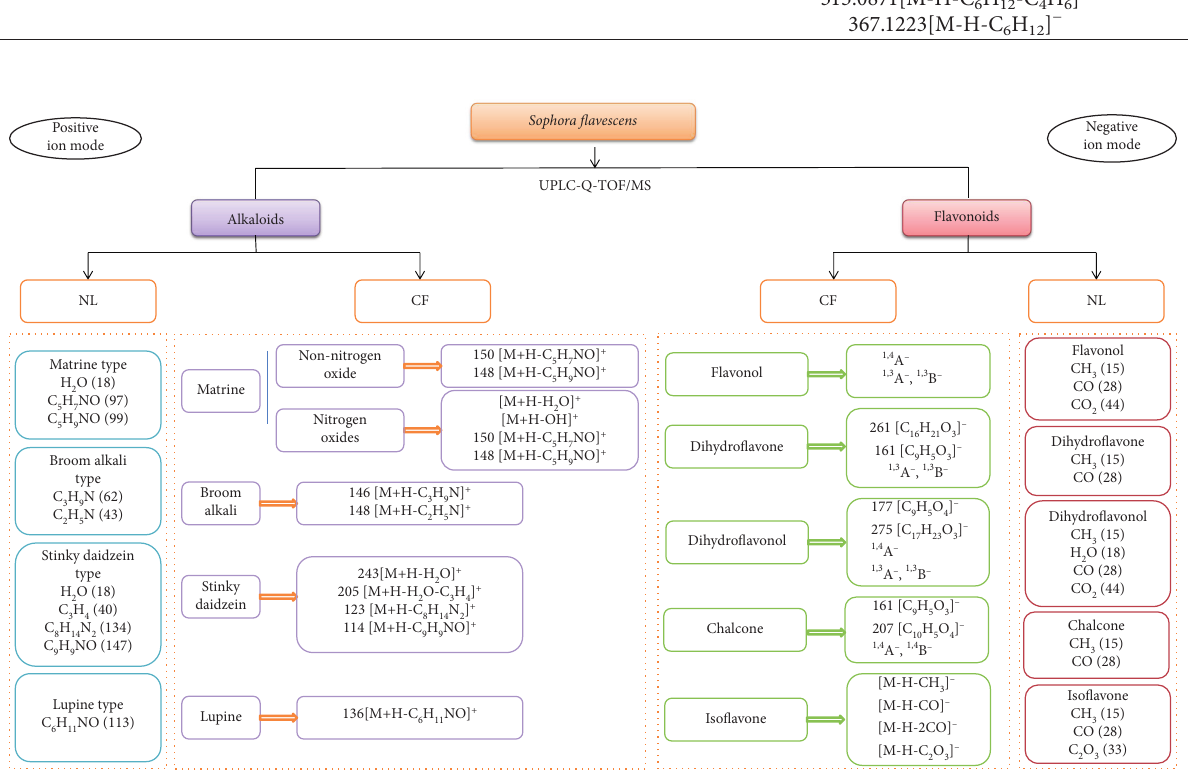
Figure 1: Characteristic fragments and neutral loss of the chemical composition of Sophora flavescens